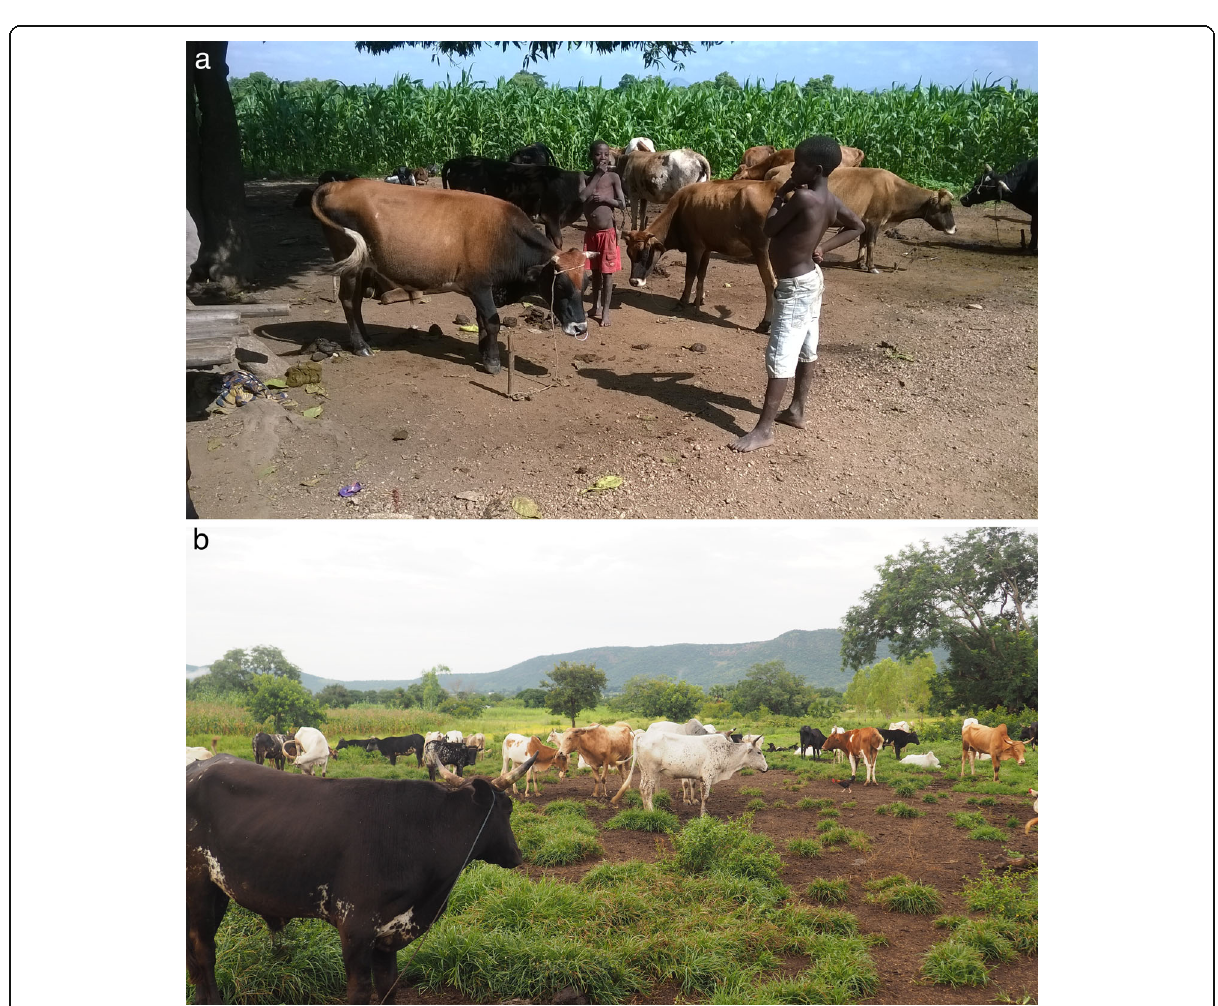
Fig. 2 Owner-managed Somba herd ( a ). Entrusted Somba herd with Zebu and cross-breeds ( b